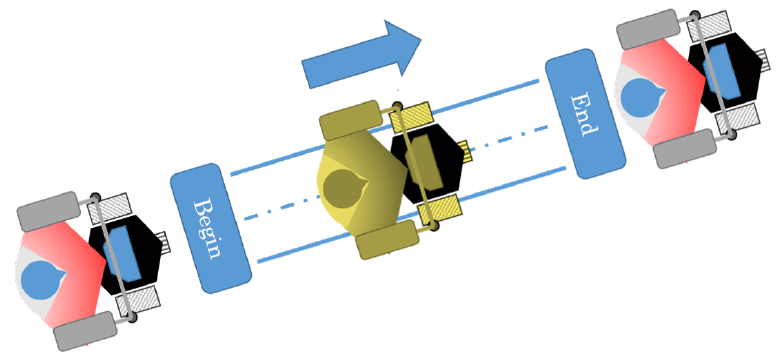
Figure 18. Straight path where the user guided the robot. The human walked through that path, and the robot helped him to perform such an action. The human guides the robot, not the